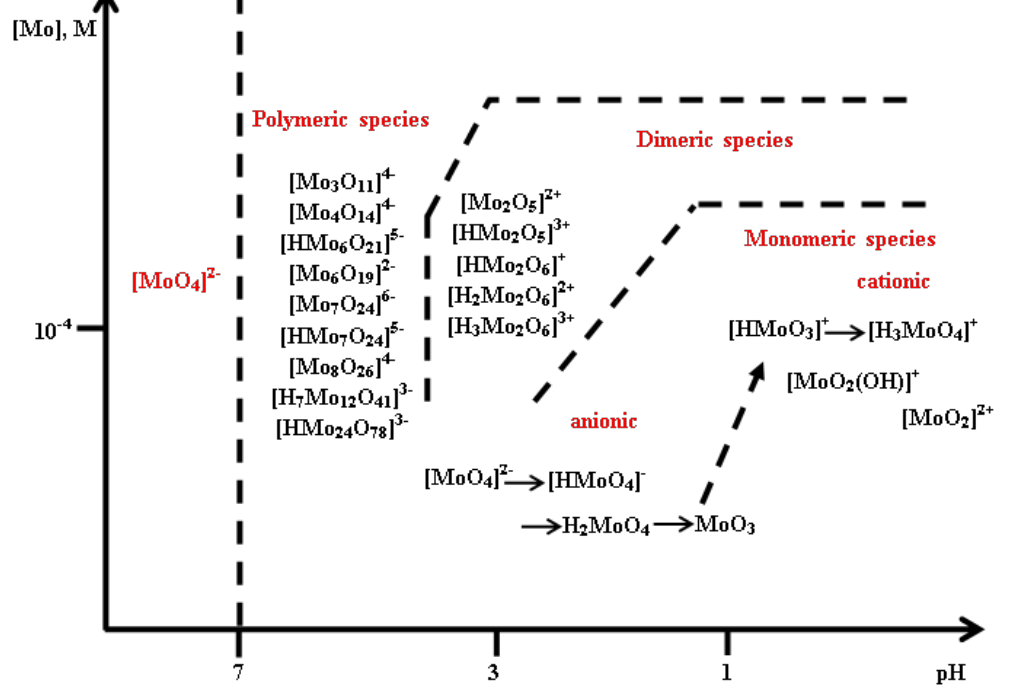
Figure 8. The polymerization degree of oxomolybdate versus pH. Adapted from Ref. [65], Copyright 2004, American Chemical Society.